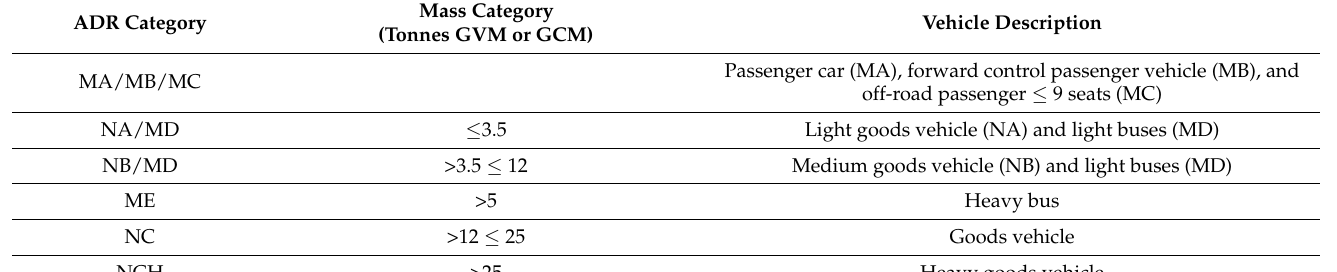
Table 2. Australian Design Rule categories for vehicle classification [58,59].